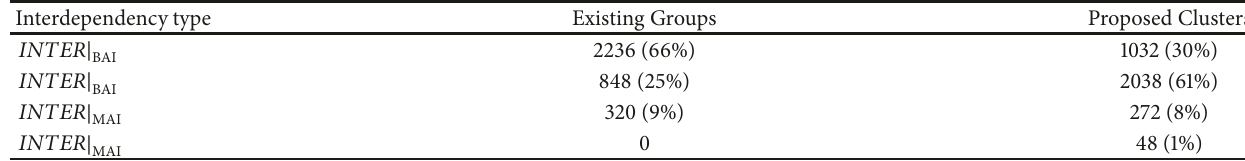
Table 1: Comparison of interdependency type sharing between existing and proposed configurations.